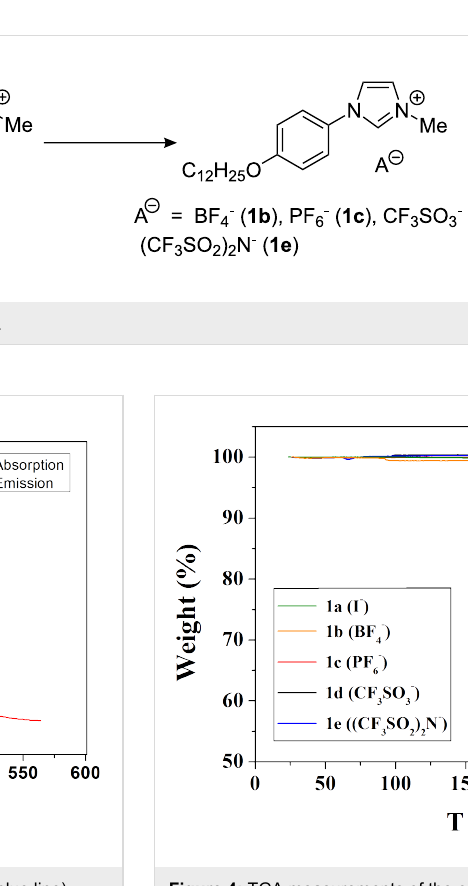
Figure 3: Spectra of absorption (red line) and emission (blue line) of 1a .